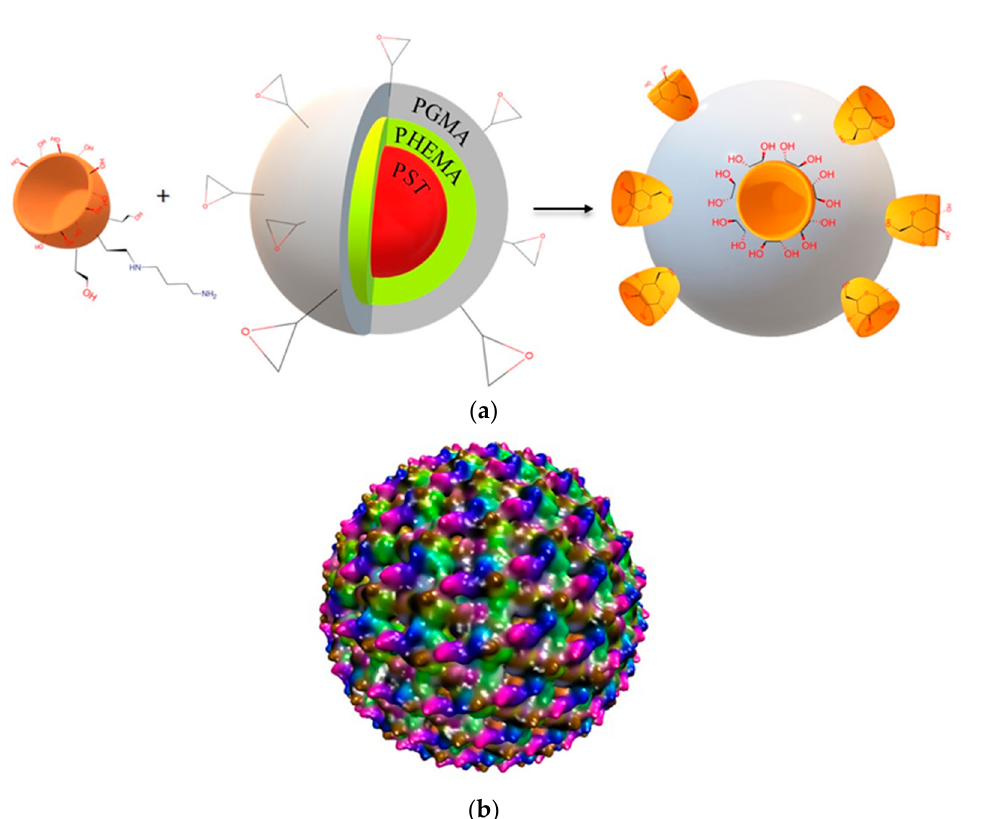
Scheme 2. Chemical synthesis of ST-HEMA-GMA-BCD-NH 2 . ( a ) The reaction of BCD-NH2 with ST-HEMA-GMA; ( b ) ST- HEMA-GMA-BCD-NH2 complex structure